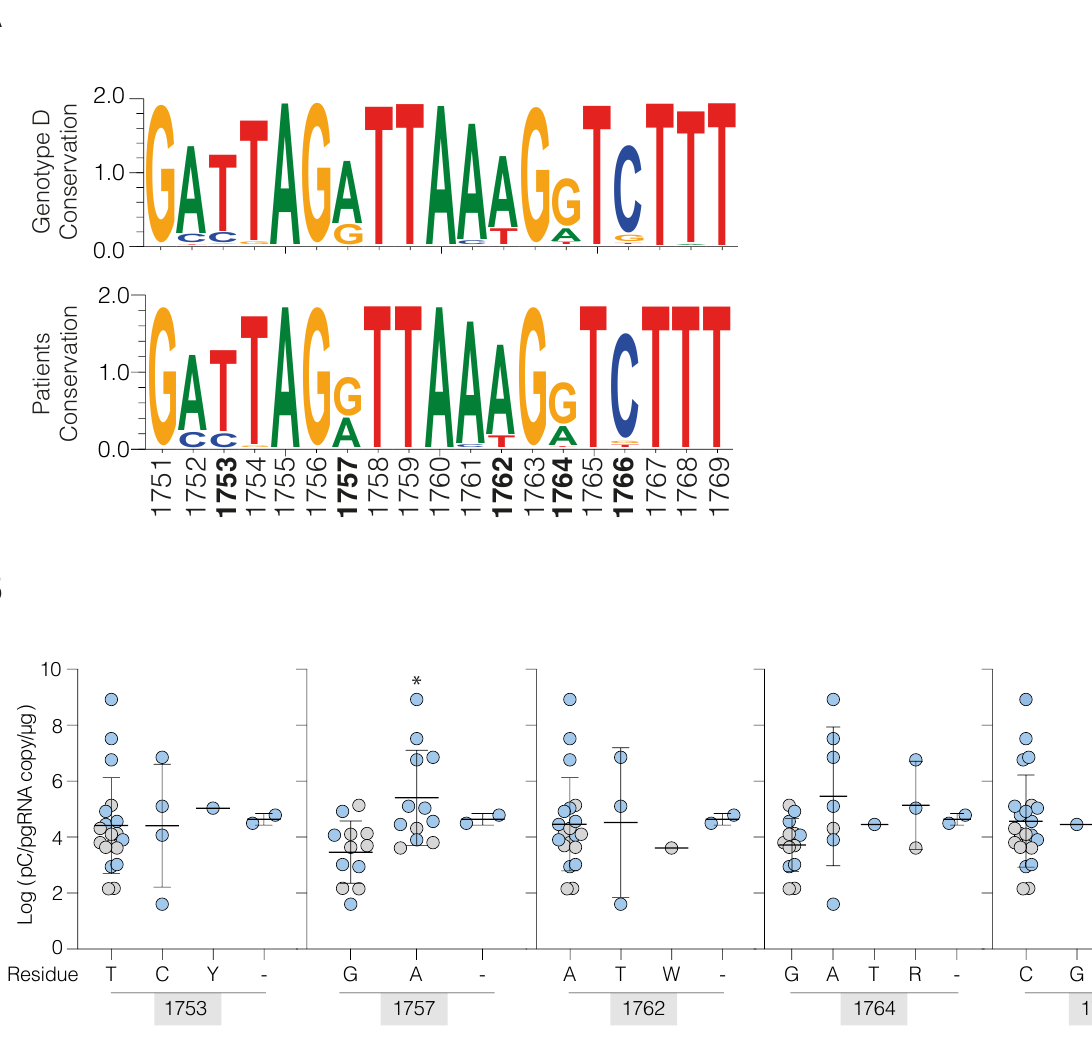
Figure 2. Basal core promoter polymorphisms and pC/pg RNA levels. ( A ) Consensus plot of the BCP region (1751–1769) of 1202 HBV genotype D sequences (HBV data base) and 26 CHB patient-derived sequences showing genetic variability. ( B ) Patients were grouped by the consensus nucleotide at previously reported residues of interest (1753, 1757, 1762, 1764, and 1766). Symbols show the mean pC/pg RNA copy number derived from two technical replicates where symbols represent ENCI (grey symbols) and ENCH (blue symbols). Differences were assessed using Kruskal–Wallis ANOVA with Dunn’s multiple comparison correction (* p <